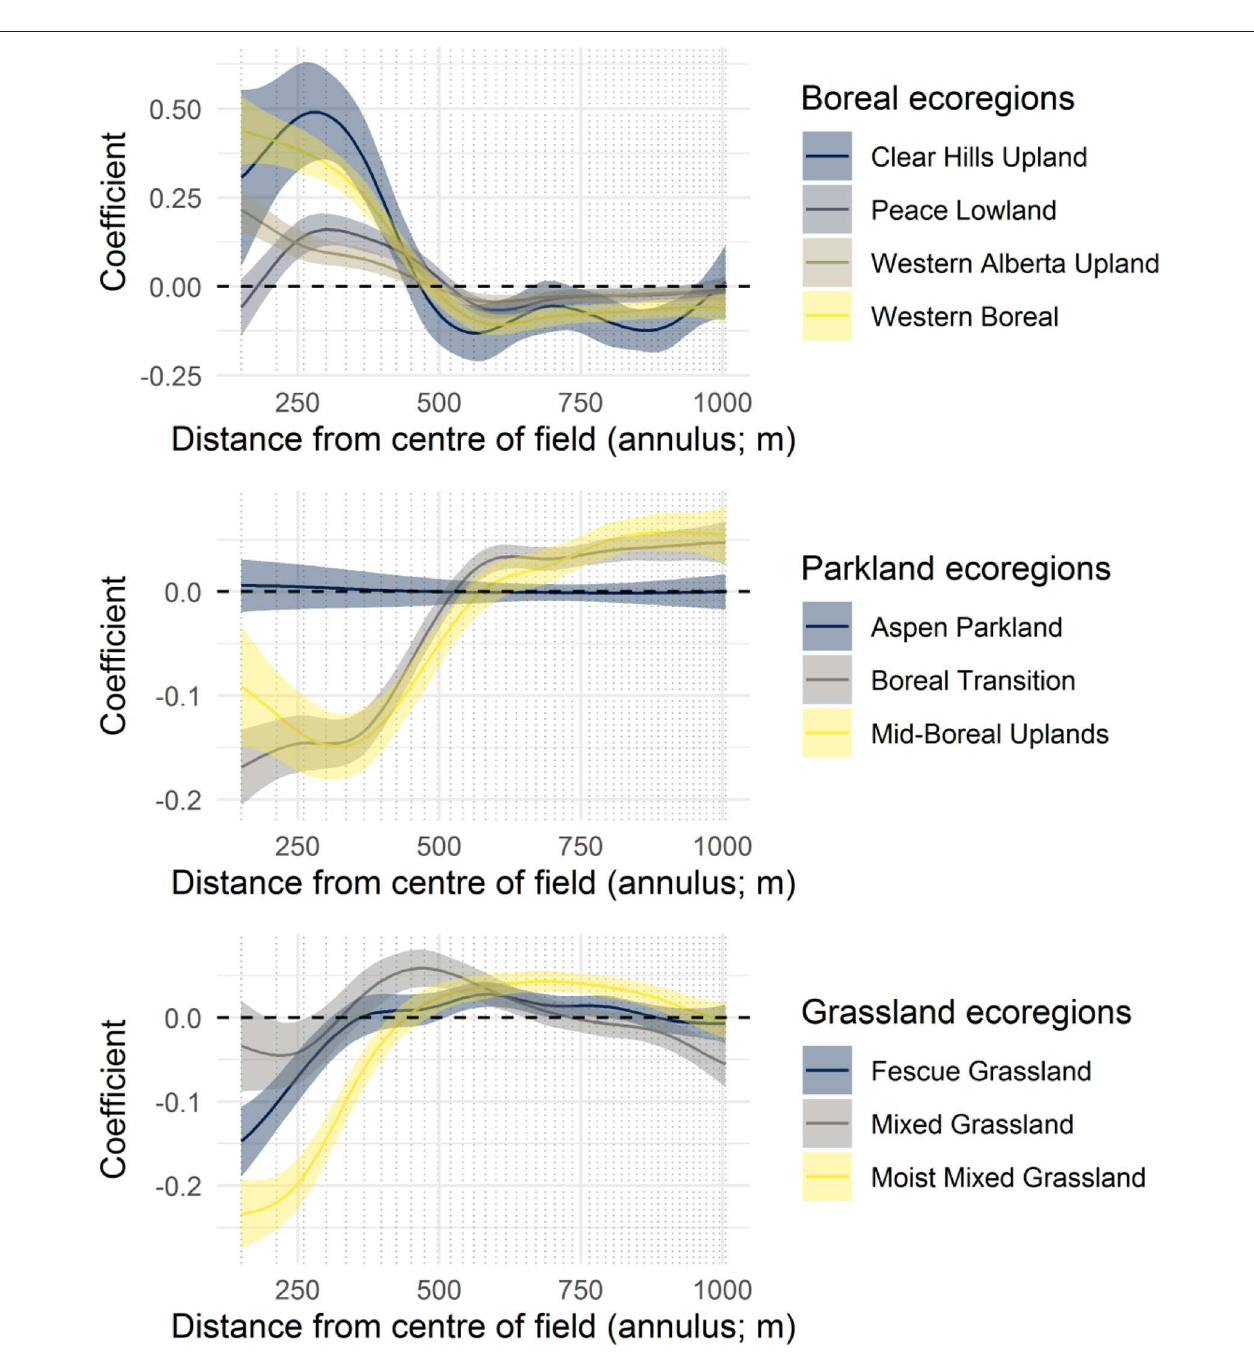
FIGURE 5 | The coefficient functions for twelve ecoregions, grouped by their dominant non-crop vegetation. Curves demonstrate deviations from the mean landscape complexity curve ( Figure 3 ).